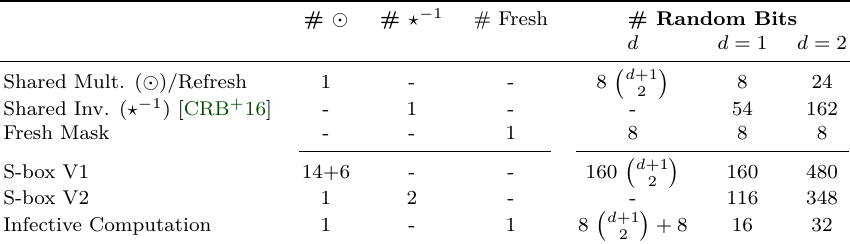
Table 1: Randomness Cost for the AES S-box implementations # (cid:12)